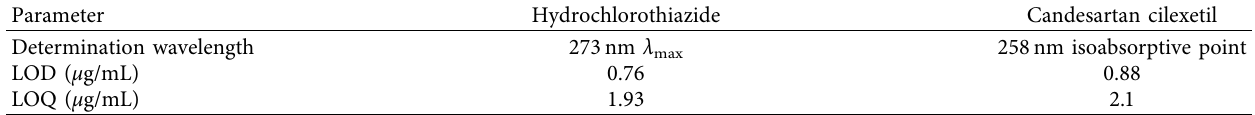
Table 6: LOD and LOQ for HCT and CAN by the Q -absorbance ratio method.